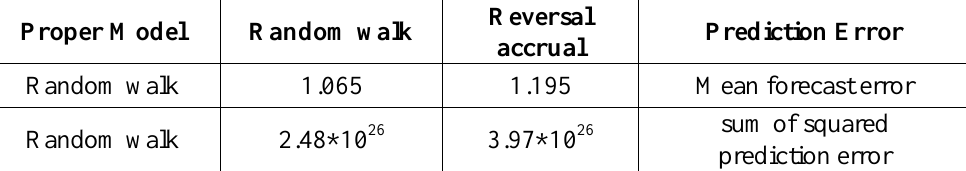
Table 3. Comparison of Random Walk and Reversal Accrual Models Proper